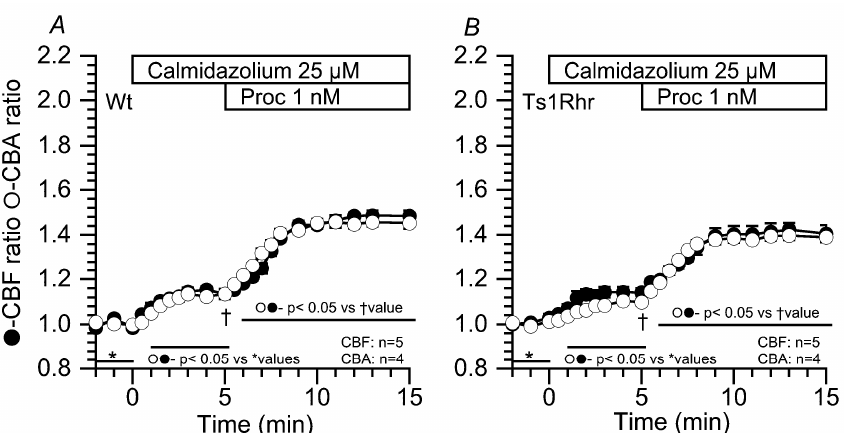
Figure 5. Effects of calmidazolium on the procaterol-stimulated CBF and CBA increases. The